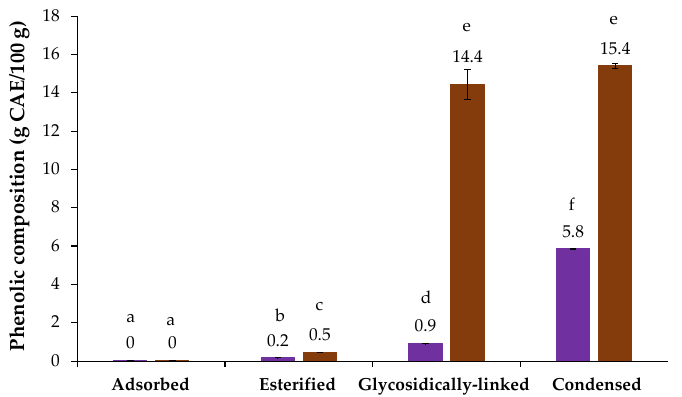
Figure 2. Phenolic composition (g caffeic acid equivalents (CAE)/100 g of sample) of chicory (purple bars) and coffee (brown bars) high molecular weight material. Lowercase letters refer to significantly different values ( p < 0.05) among the samples. Table 2. Phenolic compounds identified in the high molecular weight material of instant chicory and instant